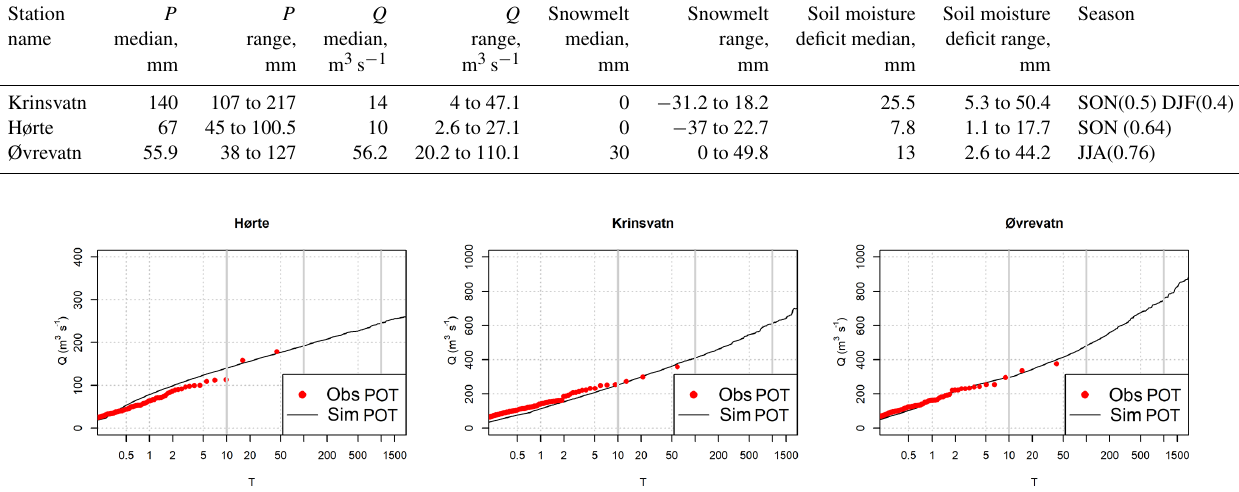
Figure 7. Comparison between the observed and simulated flood frequency curves of peak discharge for Hørte, Krinsvatn and